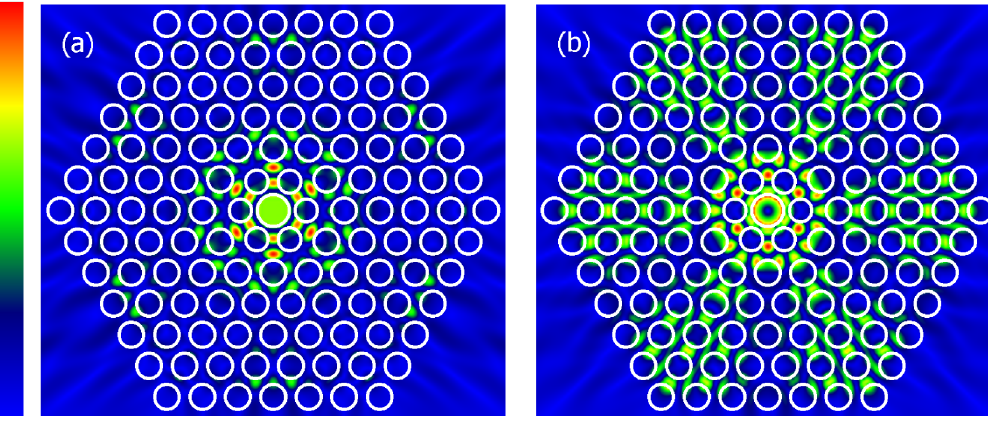
FIG. 10. (a) Longitudinal and (b) radial electric field intensities calculated with the multipole method for the TM defect mode of the 9.8-micron